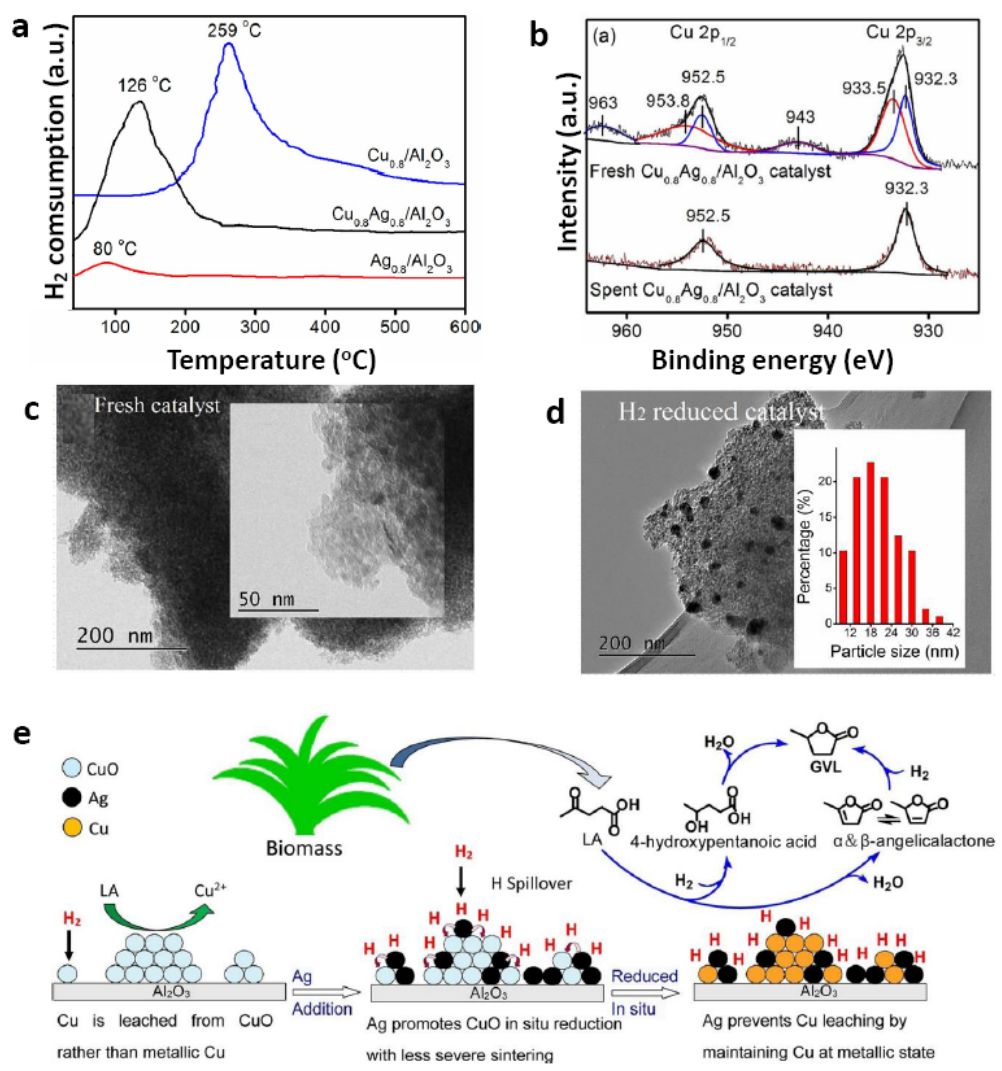
Figure 12. ( a ) TPR profiles of catalysts including Cu 0.8 /Al 2 O 3 , Cu 0.8 Ag 0.8 /Al 2 O 3 and Ag 0.8 /Al 2 O 3 . ( b ) XPS spectra in the binding energy range of Cu 2p for fresh and spent Cu 0.8 Ag 0.8 /Al 2 O 3 . ( c ) TEM image of fresh Cu 0.8 Ag 0.8 /Al 2 O 3 . ( d ) TEM image of H 2 ‐ reduced Cu 0.8 Ag 0.8 /Al 2 O 3 catalyst. ( e ) Schematic illustration of the proposed mechanism for in situ reduction, metal leaching prevention and reaction pathway. Reproduced with permission from Reference [39]. Copyright 2018, Elsevier Ltd.